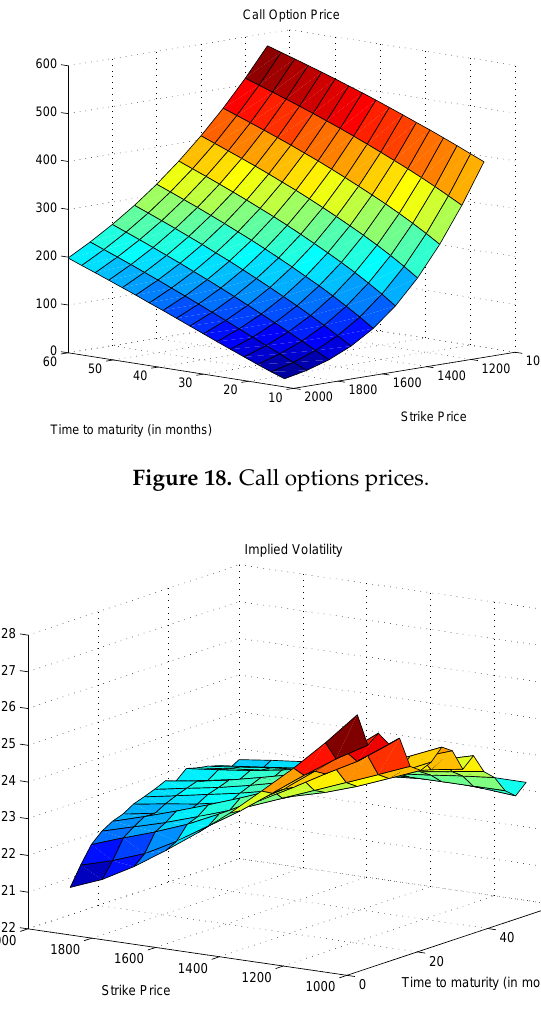
Figure 19. Implied volatility surface–S&P